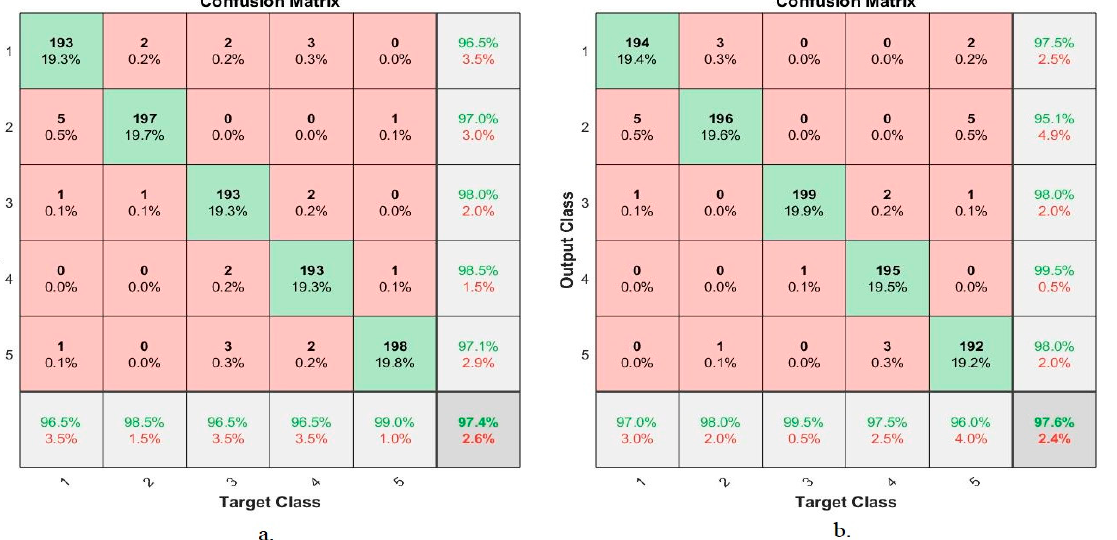
Figure 16. Confusion matrix for the low GI dataset generated by using ( a ) ANN ( b ) FFNN.